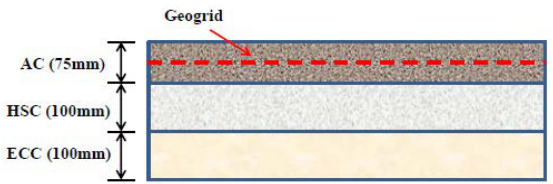
Figure 7. Cross-section of the multi-layer pavement slab. HSC, high strength concrete; ECC, engineering cementitious composite.